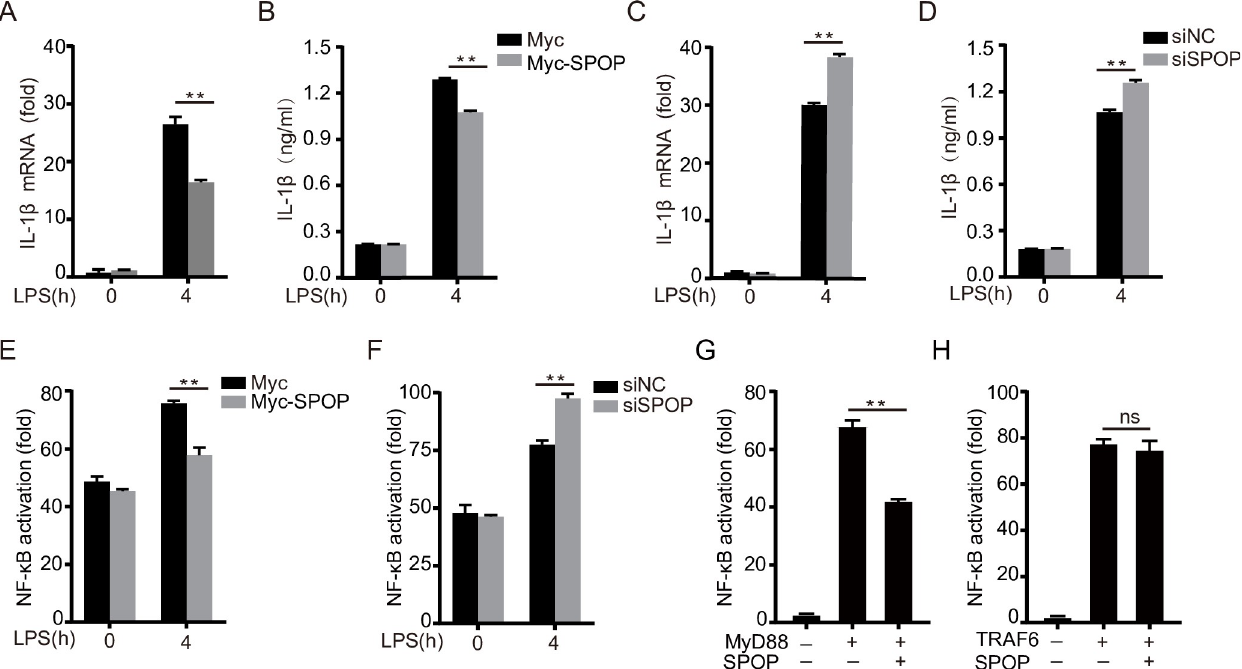
Fig 4. ChSPOP negatively regulates NF- κ B signaling and IL-1 β production. (A) and (B) IL-1 β mRNA and protein levels in chicken HD11 macrophages and cell supernatants respectively, with overexpressed chSPOP and stimulated with LPS for 4 h. (C) and (D) IL-1 β mRNA level in cells and protein level in cell supernatants from chicken HD11 macrophages transfected with chSpop siRNA and stimulated with LPS for 4 h. (E) Relative luciferase activity of NF- κ B reporter in chicken HD11 macrophages overexpressing chSPOP. (F) Relative luciferase activity of NF- κ B reporter in chicken HD11 macrophages transfected with chSpop siRNA. These data are representative of three independent experiments. (G) and (H) Luciferase activity driven by NF- κ B promoter in chicken DF1 cells transfected with chSPOP and chMyD88 or chTRAF6. Luciferase assays were performed 24 h after transfection. �� p < 0.01 and error bars reflect ±